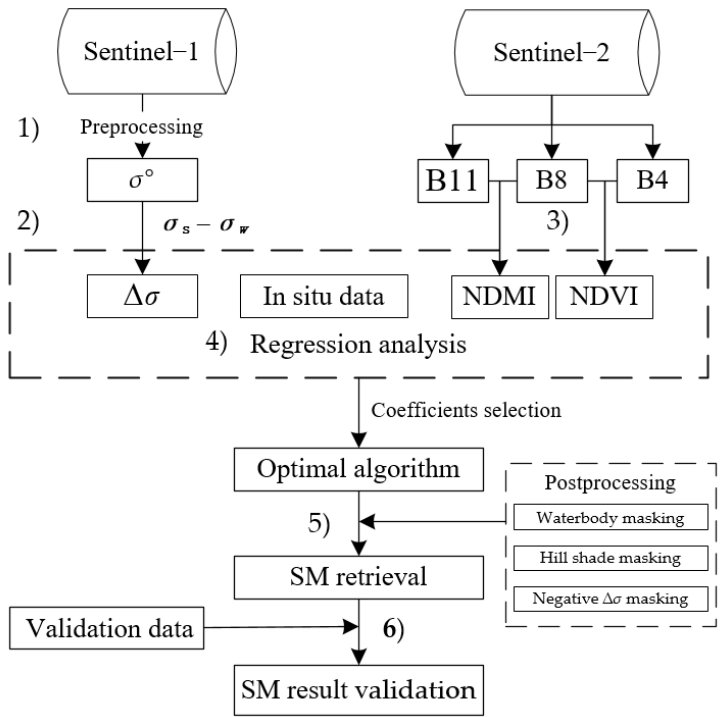
Figure 2. Workflow of SM retrieval and validation.